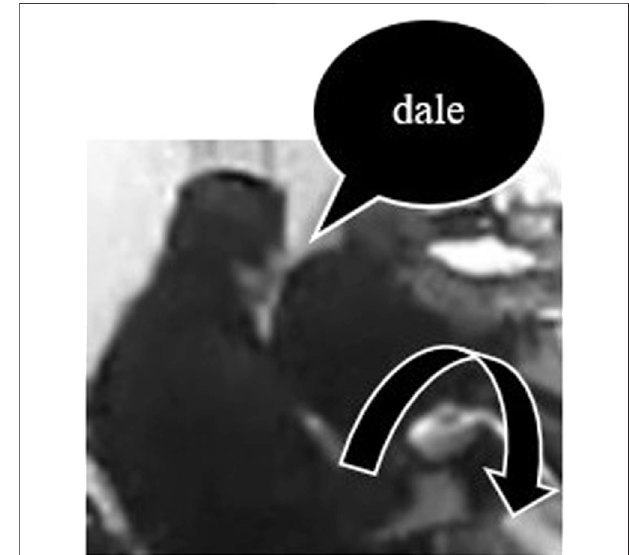
FIGURE 12 | Extract 5. line 6.